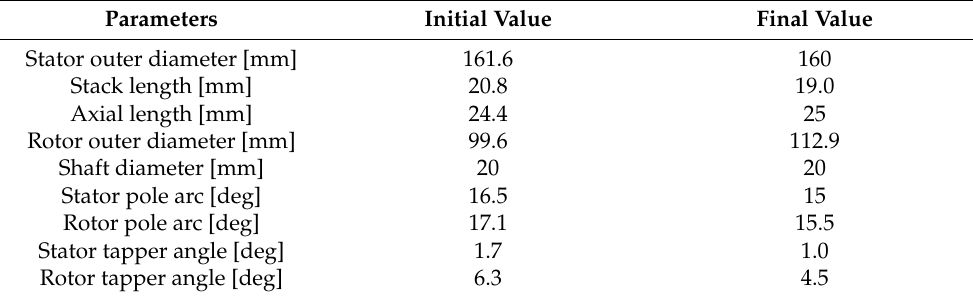
Table 4. Dimension comparison.